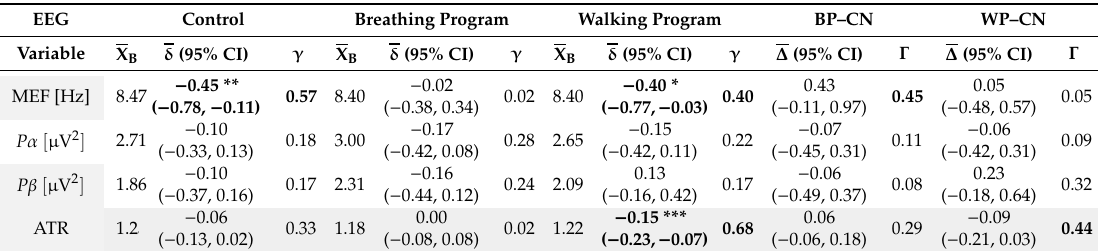
Table 3. Changes in EEG variables after the forest therapy programs (FTPs) (analysis of covariance (ANCOVA)